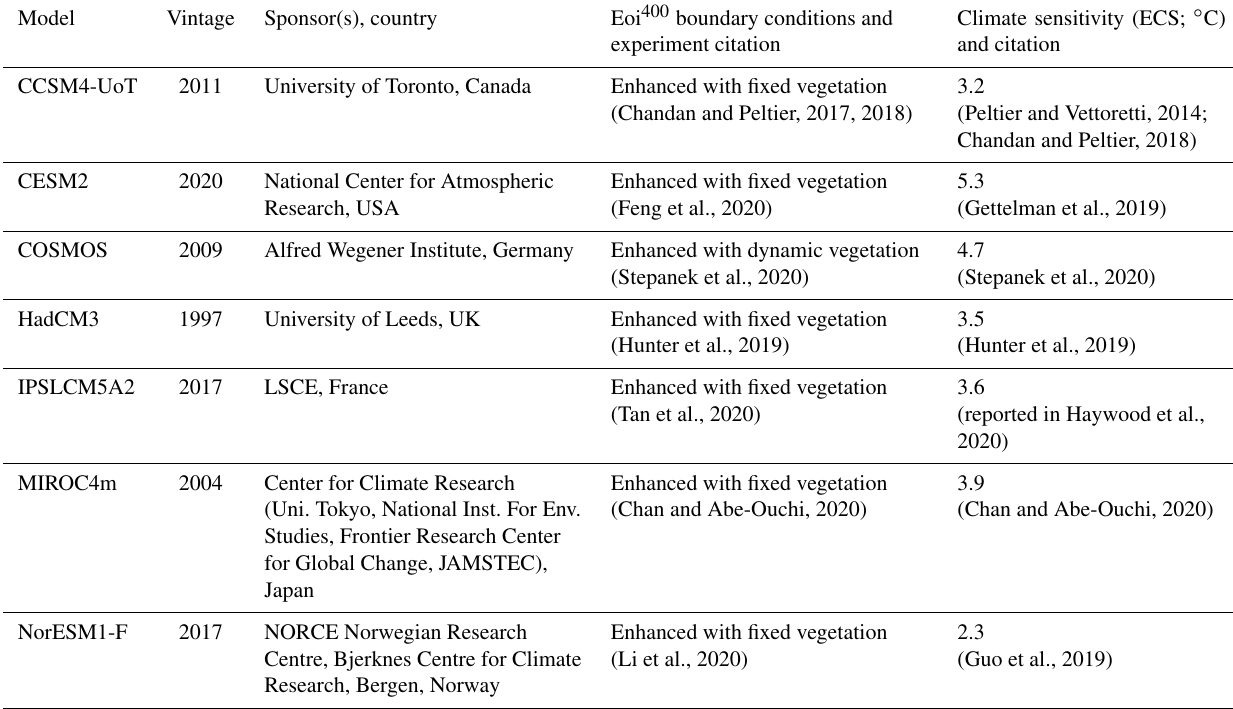
Table 2. Details of the climate models used in the FCO 2 analysis (adapted from Haywood et al., 2020). Model